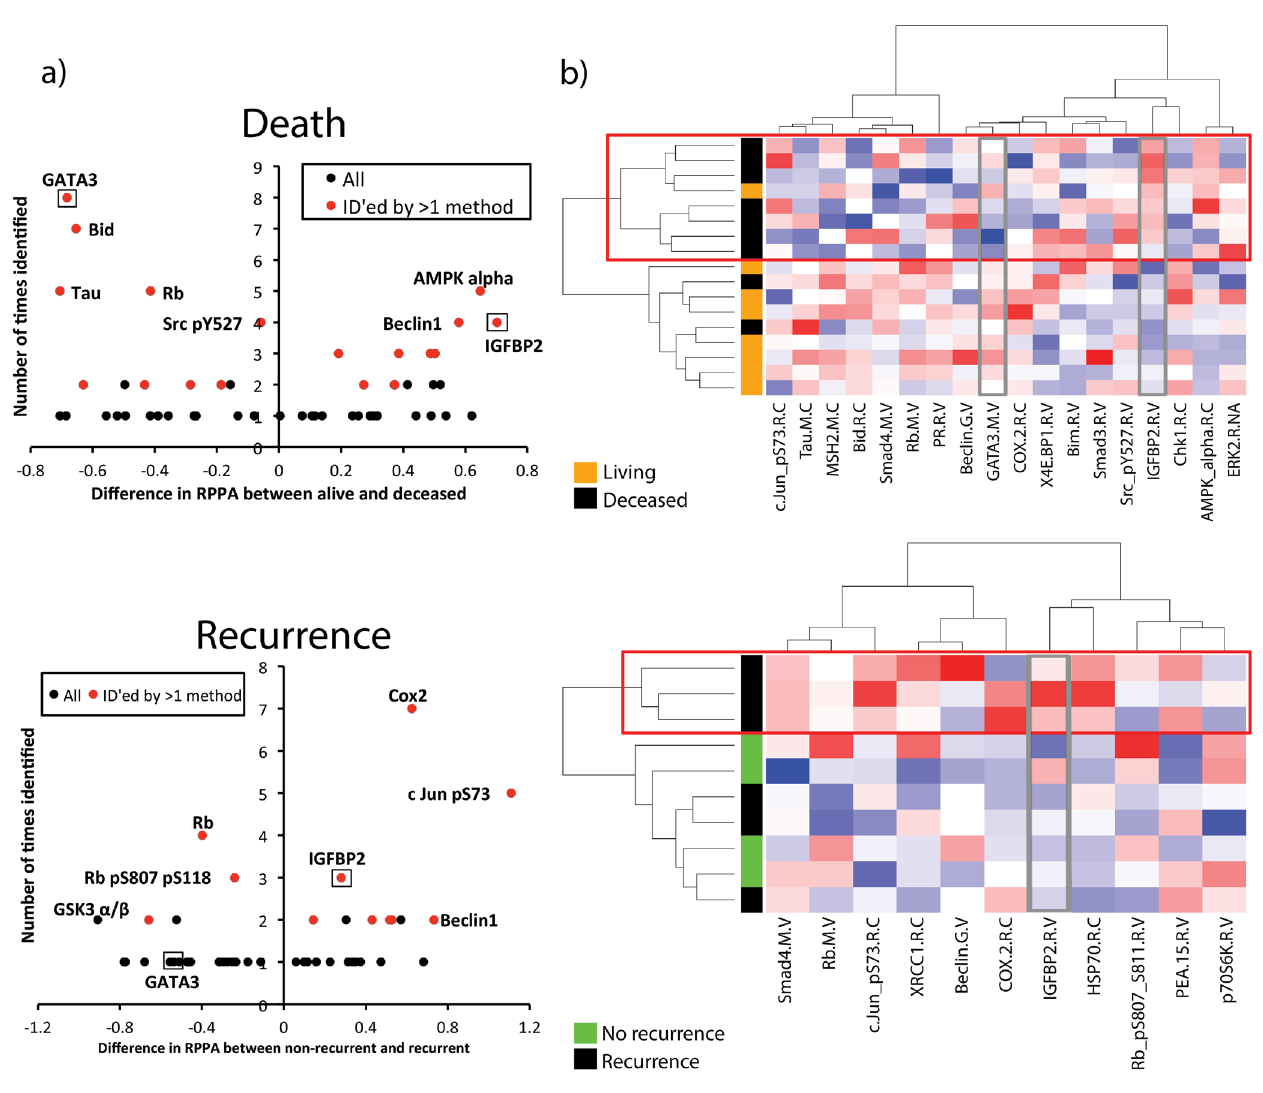
Figure 1. Visualization of proteins identified by bioinformatics analysis. a ) Volcano plots were created by plotting the difference in the scaled RPPA expression for each protein vs. the number of times that protein was identified in the bioinformatics analysis. A positive value on the y-axis means that protein is upregulated in poor prognosis (recurrent or deceased) patients, while negative value on the y-axis means that protein is downregulated in poor prognosis (recurrent or deceased) patients. Proteins identified by more than one bioinformatics method (Table 3, Table 4) are shown in red, and proteins selected for further analysis are boxed and labeled. b ) Heatmaps were created using unsupervised clustering of all top hits (Table 3, Table 4) in stage I-II patients. Each row is a patient; each column is a protein. Red boxes outline poor prognosis (recurrence or death) clusters. Proteins selected for further analysis (GATA3 and IGFBP2) are outlined in grey